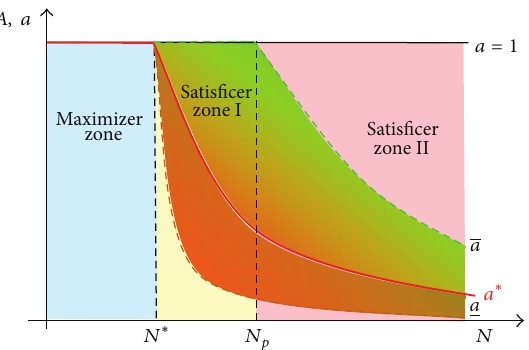
Figure 5: Model output: typical satisficer correspondence 𝐴(𝑁) and best satisficer curve 𝑎 ∗ (𝑁) . The two curves 𝑎 and 𝑎 limit the contour of the graph of 𝐴(𝑁) . They define three different satisficer regions. In the maximizer zone where 𝑎(𝑁) = 𝑎(𝑁) , welfare is optimal when all options are checked and the best satisficer is the maximizer. In the satisficer zone I, the consumer is able to choose as a maximizer but optimal welfare is obtained looking over a fraction 𝑎 ∗ of 𝑁 which is decreasing as 𝑁 increases. In the satisficer zone II, the optimal fraction is also decreasing but the consumer cannot act as a maximizer, who is experiencing choice paralysis.